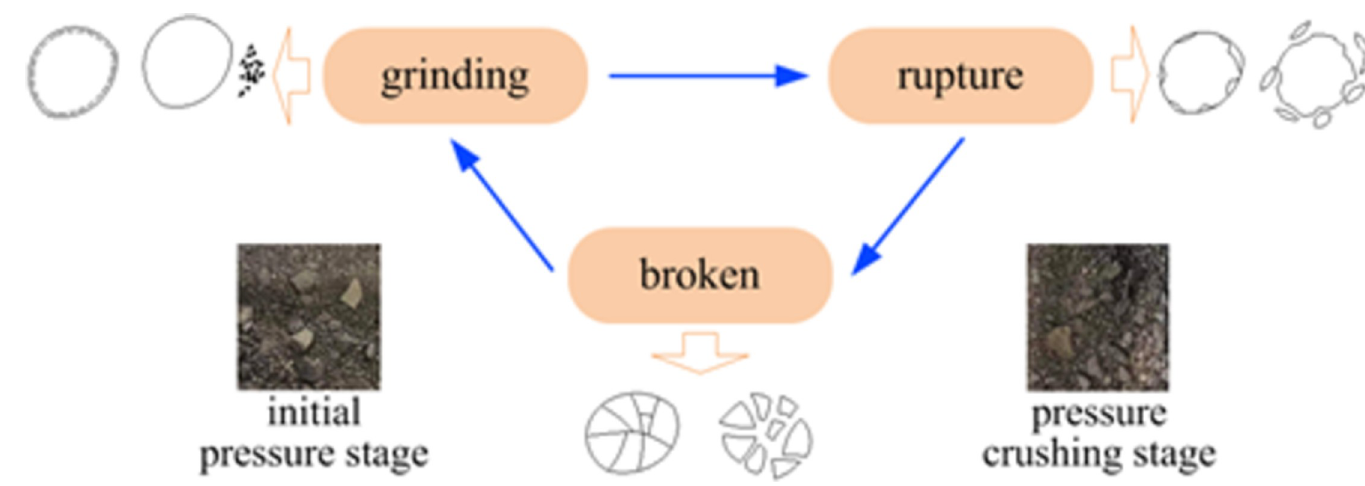
Fig 6. Structural evolution process of broken coal